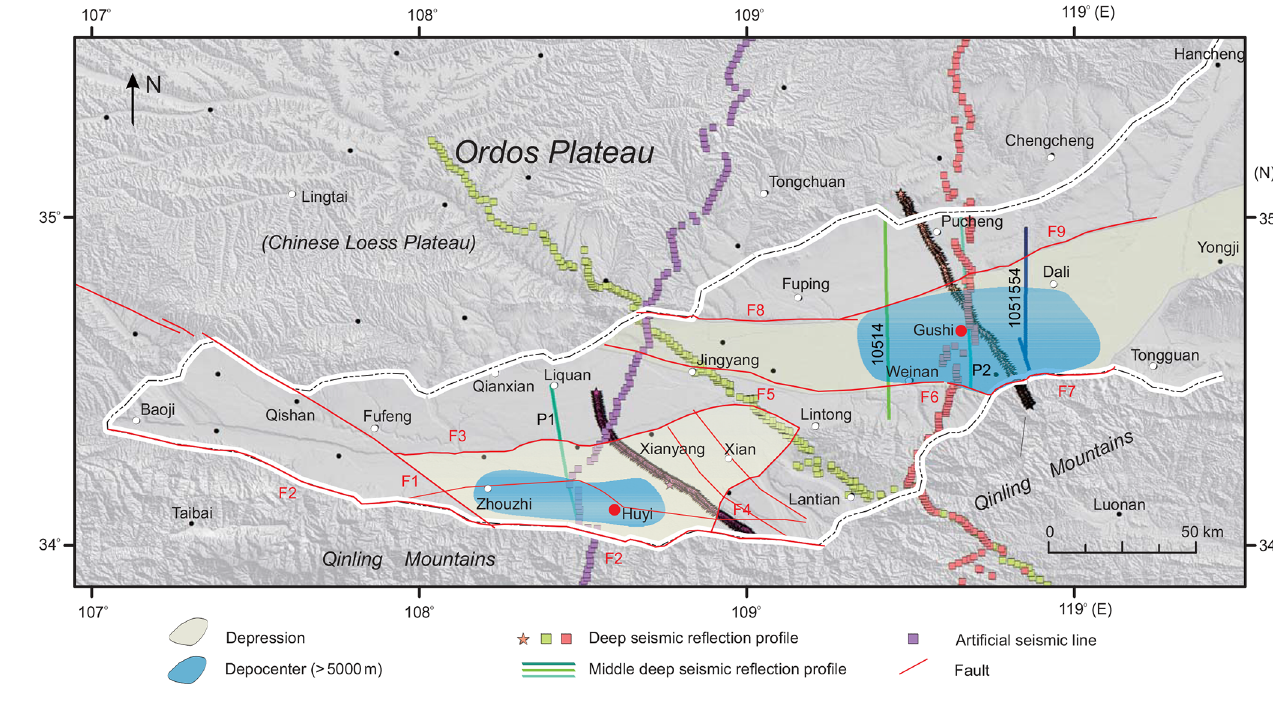
Figure 3. Geophysical surveys in the Weihe Basin.